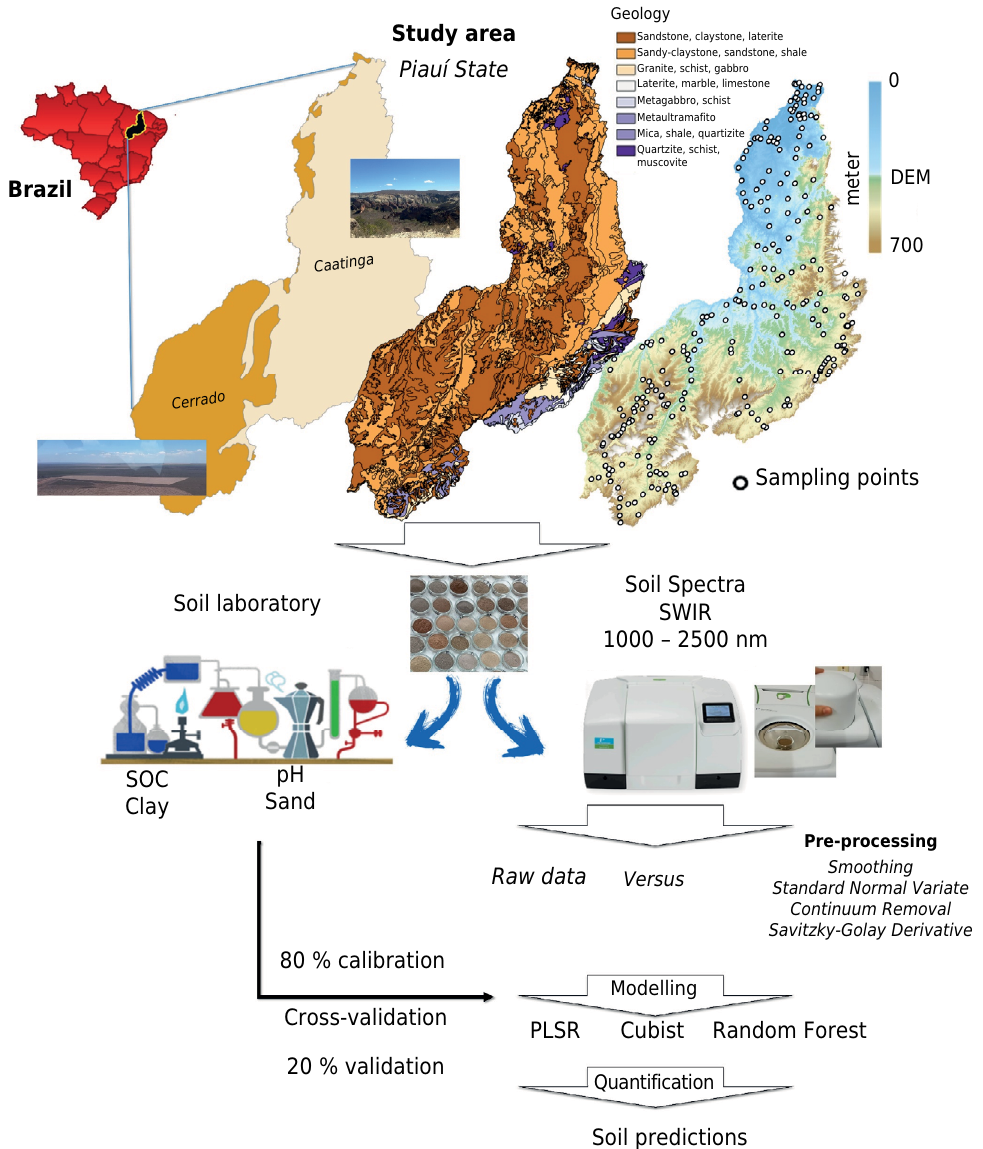
Figure 1. Methodological sequence of the